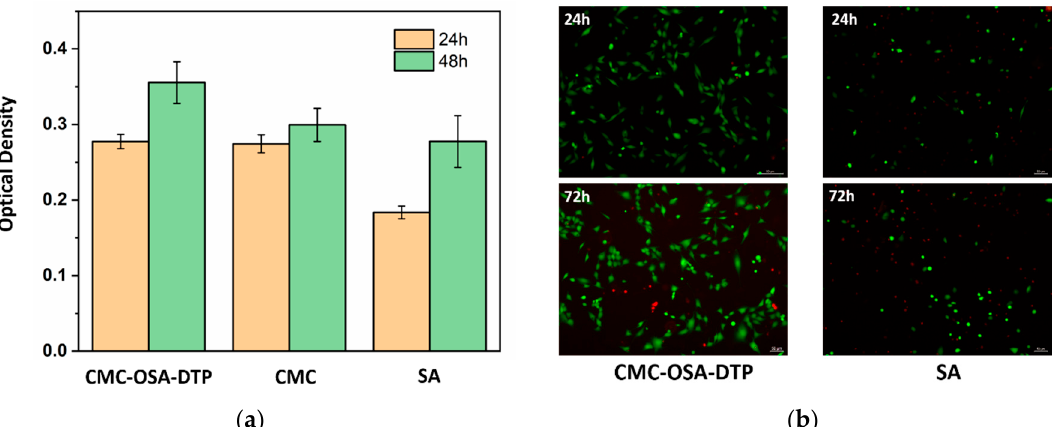
Figure 9. Cytocompatibility evaluation of hydrogels. ( a ) MG-63 cell proliferation measured 24 and 48 h after seeding on CMC-OSA-DTP hydrogel, pure alginate hydrogel (SA), and pure chitosan sticky liquid (CMC). ( b ) LIVE / DEAD assay images of MG-63 cells encapsulated within CMC-OSA-DTP hydrogel and pure alginate hydrogel (SA) for 24 h, 72 h.